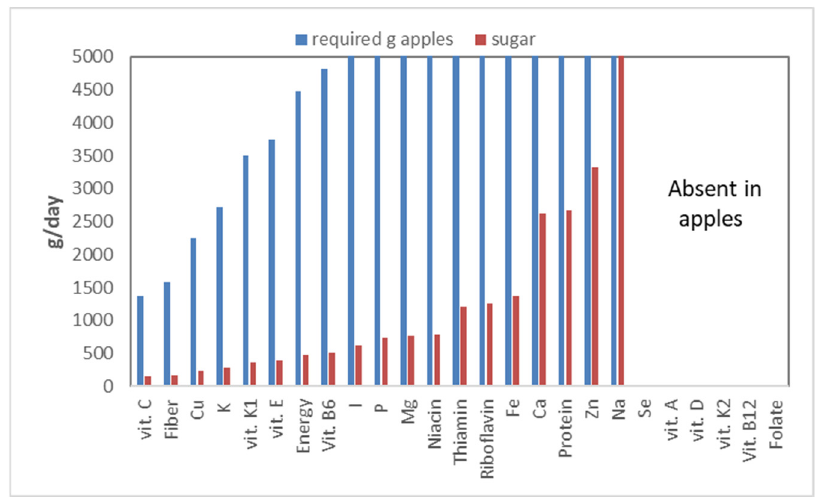
Figure 18. The amount of apple (g) one needs to eat to obtain enough of a nutrient to meet the daily requirement (RDI), and the amount of sugar associated with that intake. The graph is cut off at 5000 g, and from Se to Folate, the apples do not provide any value, so no daily intake can be calculated. Several nutrients (selenium, folate, and vitamin A, D, K 2 , B 12 ) are not provided by apples—hence no bars in Figure 18—while for iodine (I) to sodium (Na), the required intake is above 5000 g/d, or well above 500 g of sugars per day. This graph also